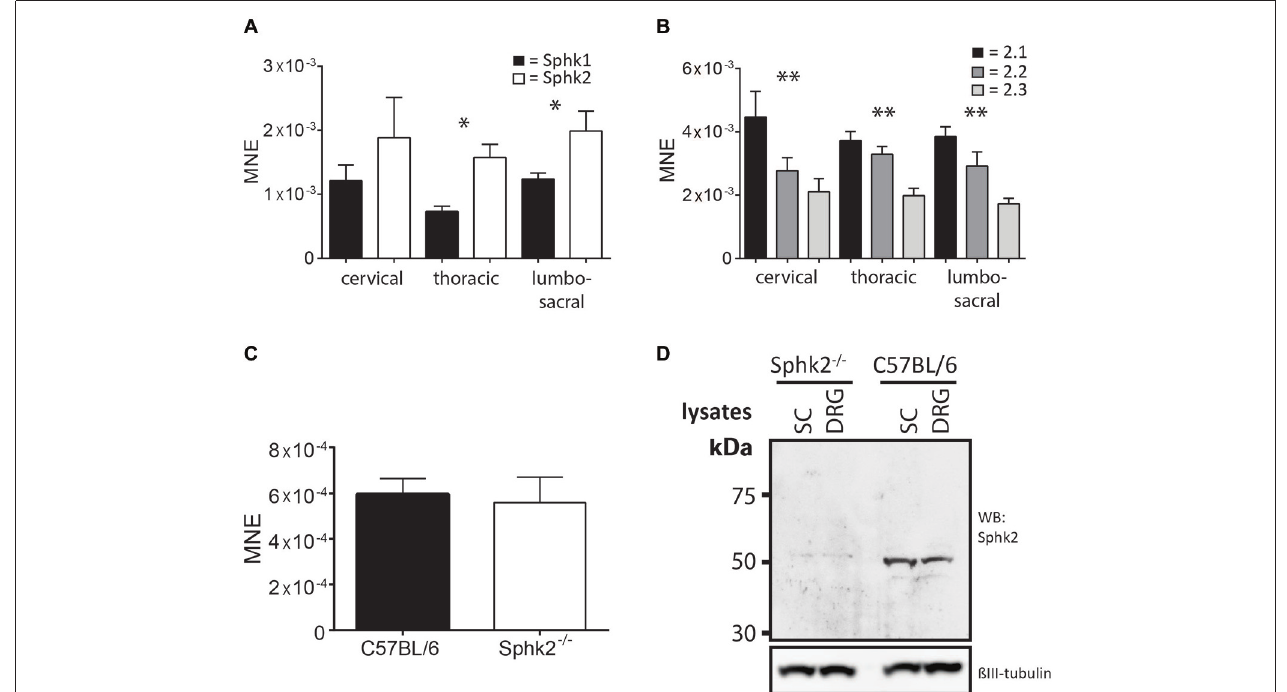
showing the highest relative mRNA-expression ( n = 5, one-way ANOVA, Bonferroni’s post hoc test, ∗∗ p < 0.01); (C) the Sphk1isoform in SC of C57BL/6 and Sphk2 − / − mice. The relative expression levels were not different between strains ( n = 5, t -test). Values are expressed as mean ± SEM. (D) Western Blot confirmed the absence of the Sphk2 protein in Sphk2-deficient mice. Sphk2 protein was present in SC and DRG and could be detected at a molecular weight of about 50 kDa. β III tubulin used as